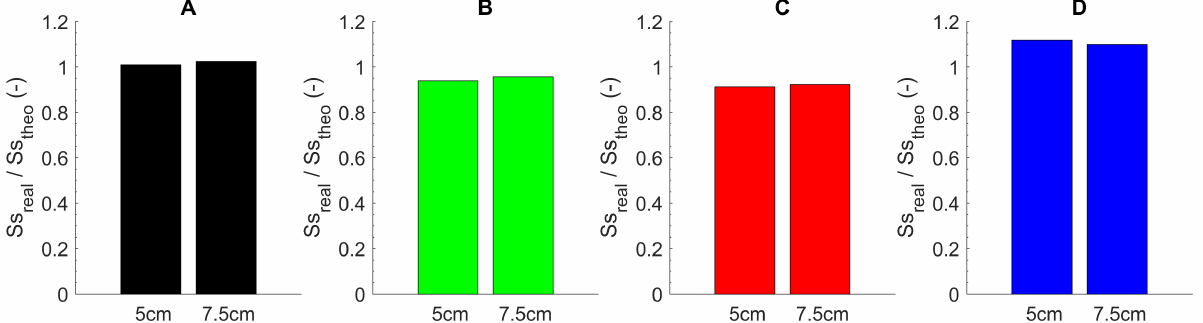
Figure 6. Ratio of realised ( S s cm and 7.5 cm sea-sate for facilities ( A – D ).